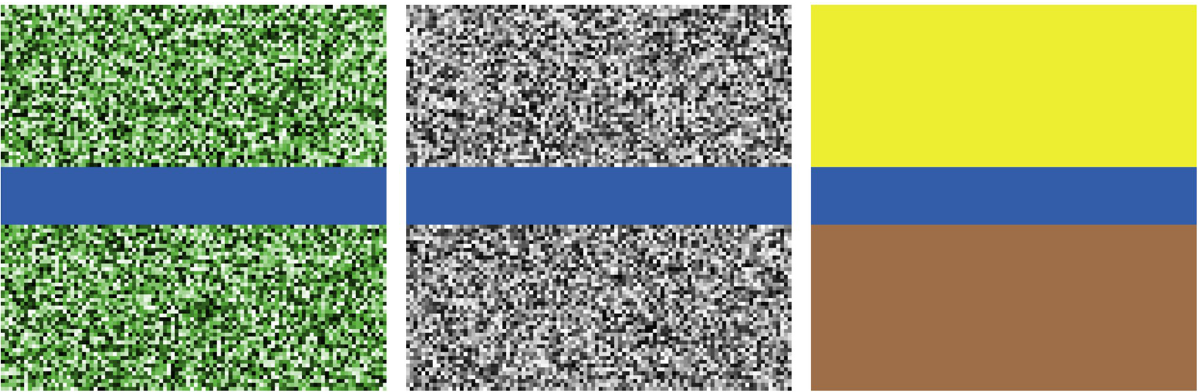
Fig 1. Default map (100 x 100 patches) with random values for resource quality and slope. Resource quality map (left), slope map (middle) and source-target map (right). The source area is shown in brown and the target area in yellow. The water barrier is shown in blue with a size of 15 patches (default level).